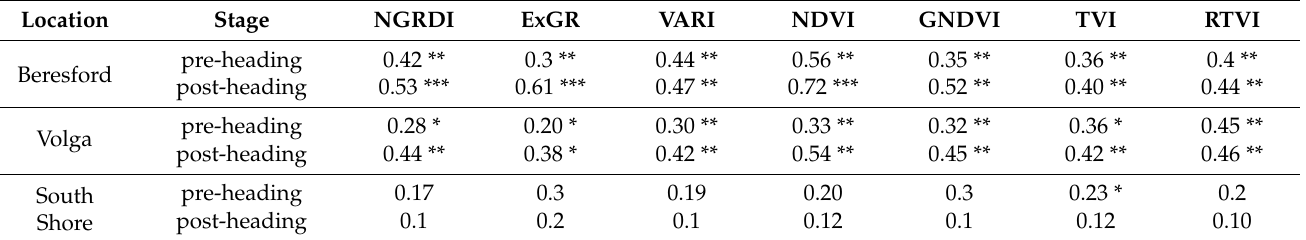
Table 5. Pearson correlation coefficients ( r ) of dry biomass yield with VIs from pre- and post-heading